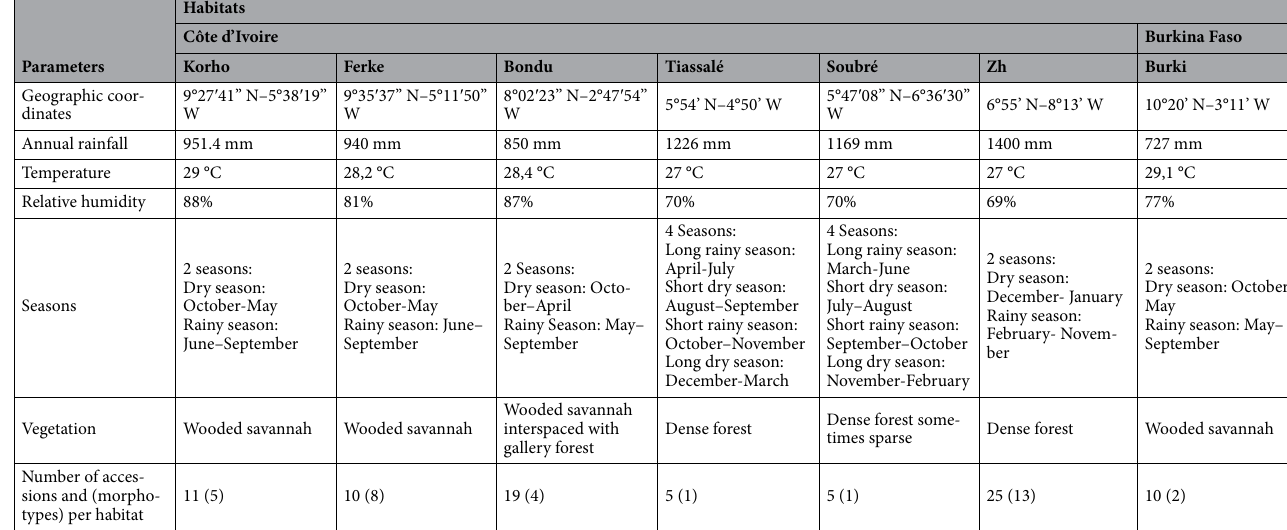
Table 4. Bioclimatic parameters, origin and distribution of the accessions of Cucurbita moschata assessed in this